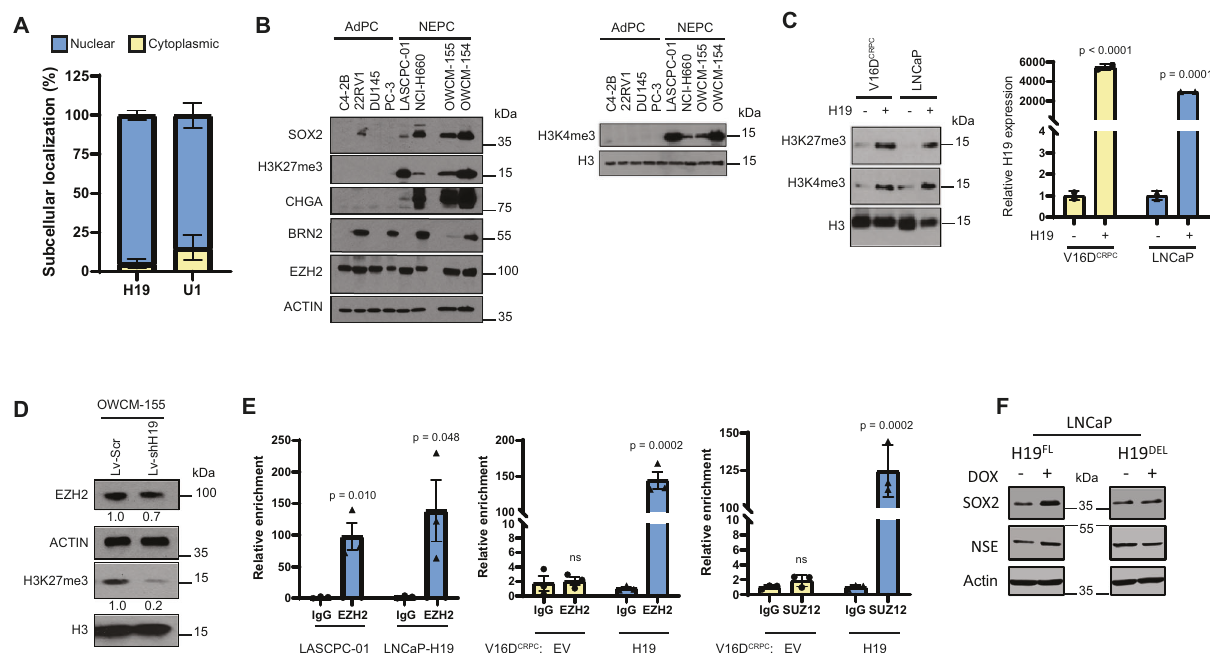
Fig. 6 H19 induces epigenetic changes including modifying histone methylation by binding to the PRC2 complex. A Nuclear localization of H19 in NCI- H660. y -Axis represents the percent abundance of RNA. Nuclear U1 RNA was used as a control. B WB of NE associated genes (SOX2, CHGA, BRN2, and EZH2), H3K27me3, and H3K4me3 in various AdPC and NEPC cell lines and organoids. C WB of H3K27me3, H3K4me3 in CRPC cell line V16D CRPC and AdPC cell line LNCaP after transient overexpression of H19 . The bar graph shows the relative H19 RNA levels in both the cell lines upon H19 overexpression. 18S was used as an endogenous control. D WB analysis of the levels of EZH2 (Actin as control) and histone H3K27me3 level (Histone H3 as control) in Control (Lv-Scr) and H19 knockdown (Lv-shH19) OWCM-155 NEPC organoids. Numerical values shown under the blot are calculated relative to the control samples. E Relative enrichment of H19 binding to PRC2 complex members EZH2, SUZ12 in LASCPC-01, LNCaP, and V16D CRPC cells with transient overexpression of control (EV) and H19 (H19). F WB analysis of LNCaP cells stably expressing doxycycline (DOX) inducible H19 FL (full-length H19 ) or H19 DEL (5 ′ deleted H19 fragment) with or without DOX treatment (200 ng/mL, 48 h). Actin was used as a control. Data are mean ± SD ( A , C ), or mean ± SEM ( E ); n = 3 ( A , C , E ) biologically independent replicates. p Values were calculated by unpaired two-tailed Student ’ s t cells as compared to V16D/CTL cells (Fig. 7A, Supplementary Data 13), with a signi fi cantly increased binding distribution in proximal promoter region <1 kb from TSS (H3K27me3 = 84%, H3K4me3 = 46%) (Fig. 7B) in cells transduced with H19 . Upon H19 overexpression, peak occupancy of H3K4me3 and H3K27me3